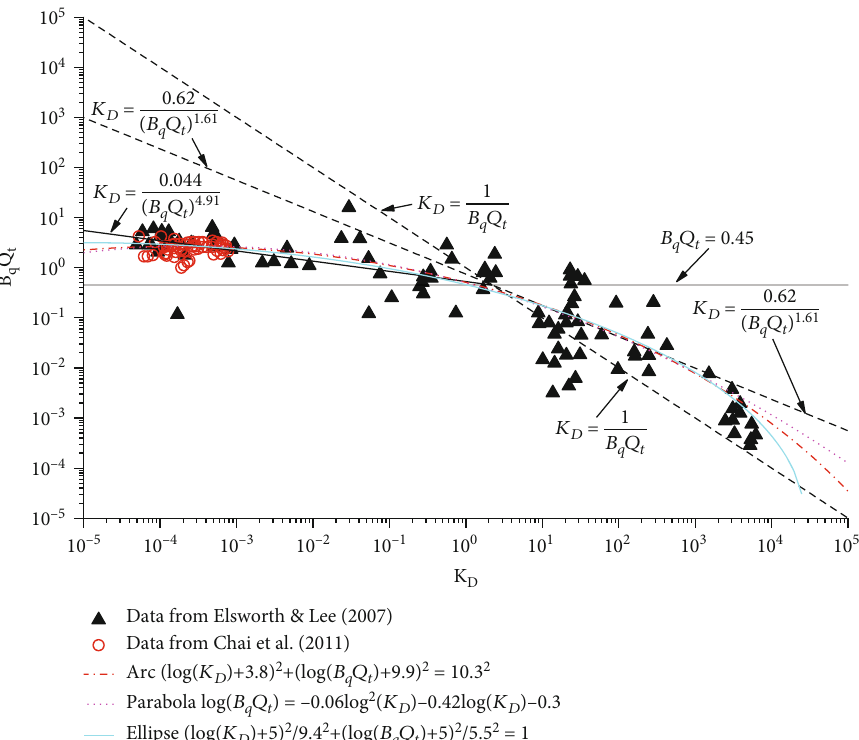
B Q D and q t from piezocone test (data from Chai